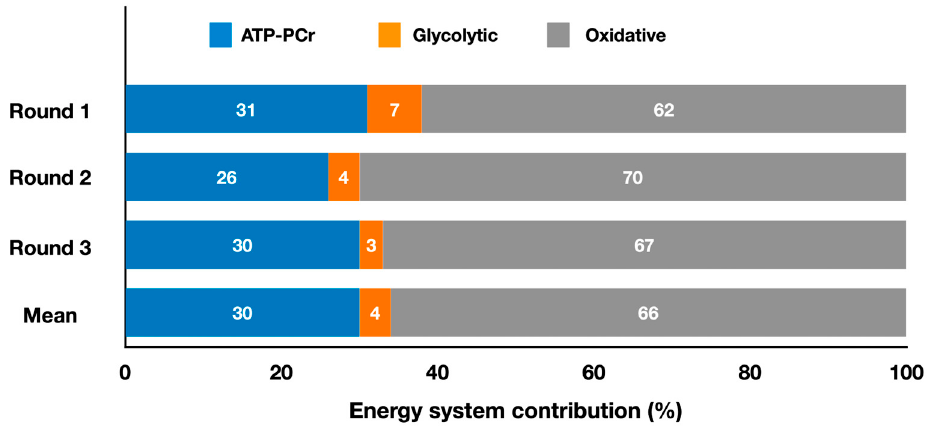
Figure 2. Contributions of the oxidative, ATP-PCr, and glycolytic systems during three 2 min rounds of a taekwondo simulated match, and the mean contributions throughout the entire match (adapted from Campos et al. [13]). The values represent the mean percentage of each energy system for each round and throughout the entire match simulation (refer to the text for specific comparisons between energy